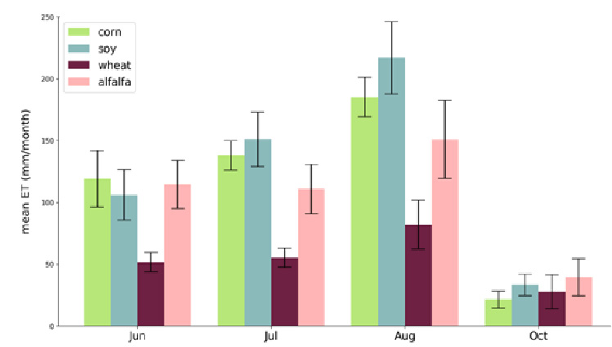
Figure 4. Monthly average ET rate for: a) June; b) July; c) August; d) October